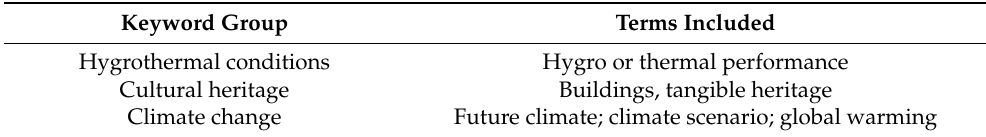
Table 1. Keywords that were used to group the terms related to different topics. Keyword Group Terms